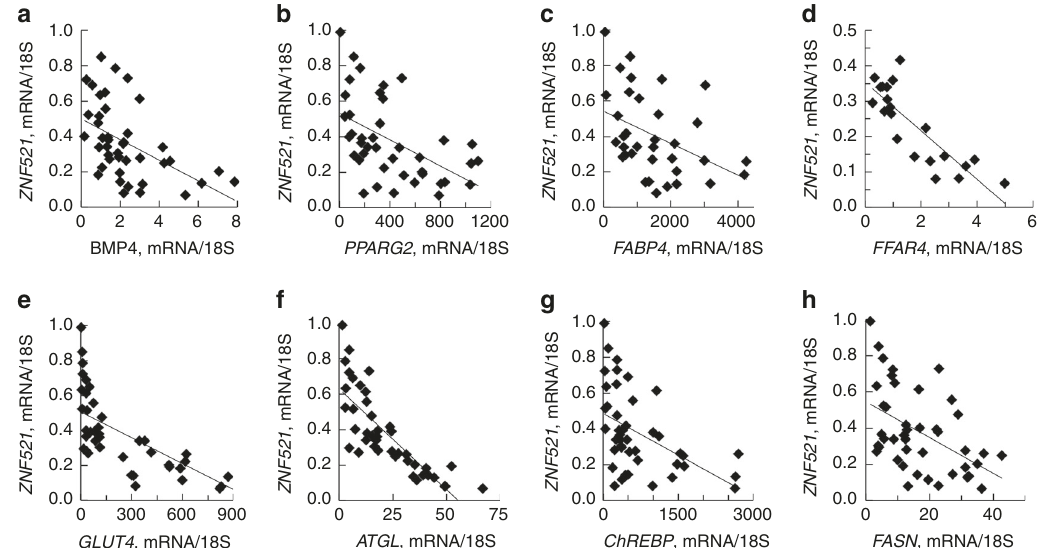
Fig. 2 ZNF521 is a key marker of adipogenic differentiation. a – e Inter-relationship between expression of the adipogenic markers and ZNF521 . FABP4 ; fatty acid binding protein 4 and GLUT4 ; solute carrier family 2 member 4 ( SLC2A4 ). f – h Inter-relationship between expression of the lipid markers palatin like phospholipase domain containing 2 ( PNPLA2 also known as ATGL ), MLX interacting protein like ( MLXIPL also known as ChREBP ) and FASN . a – h mRNA results were fi rst normalized to 18S and then normalized to expression levels in the undifferentiated sample ( = 1). Spearman ′ s correlation coef fi cient was used since ZNF521 was not normally distributed. FABP4 P < 0.01 n = 37 biological independent samples, remaining tested genes P < 0.001, n = 42